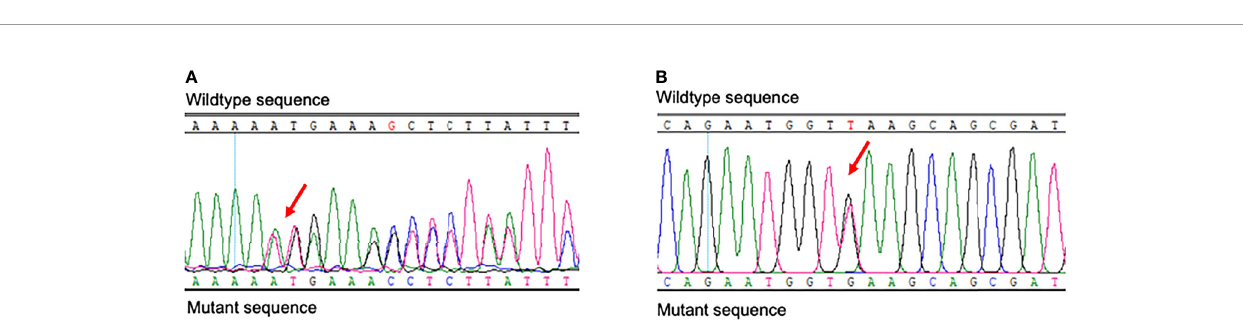
FIGURE 3 | Results of Sanger sequencing of BLM of the proband. The red arrows indicate the c.1544delA (p.Asn515Metfs*16) (A) and c.692T>G (p.Leu231*) (B) heterozygous